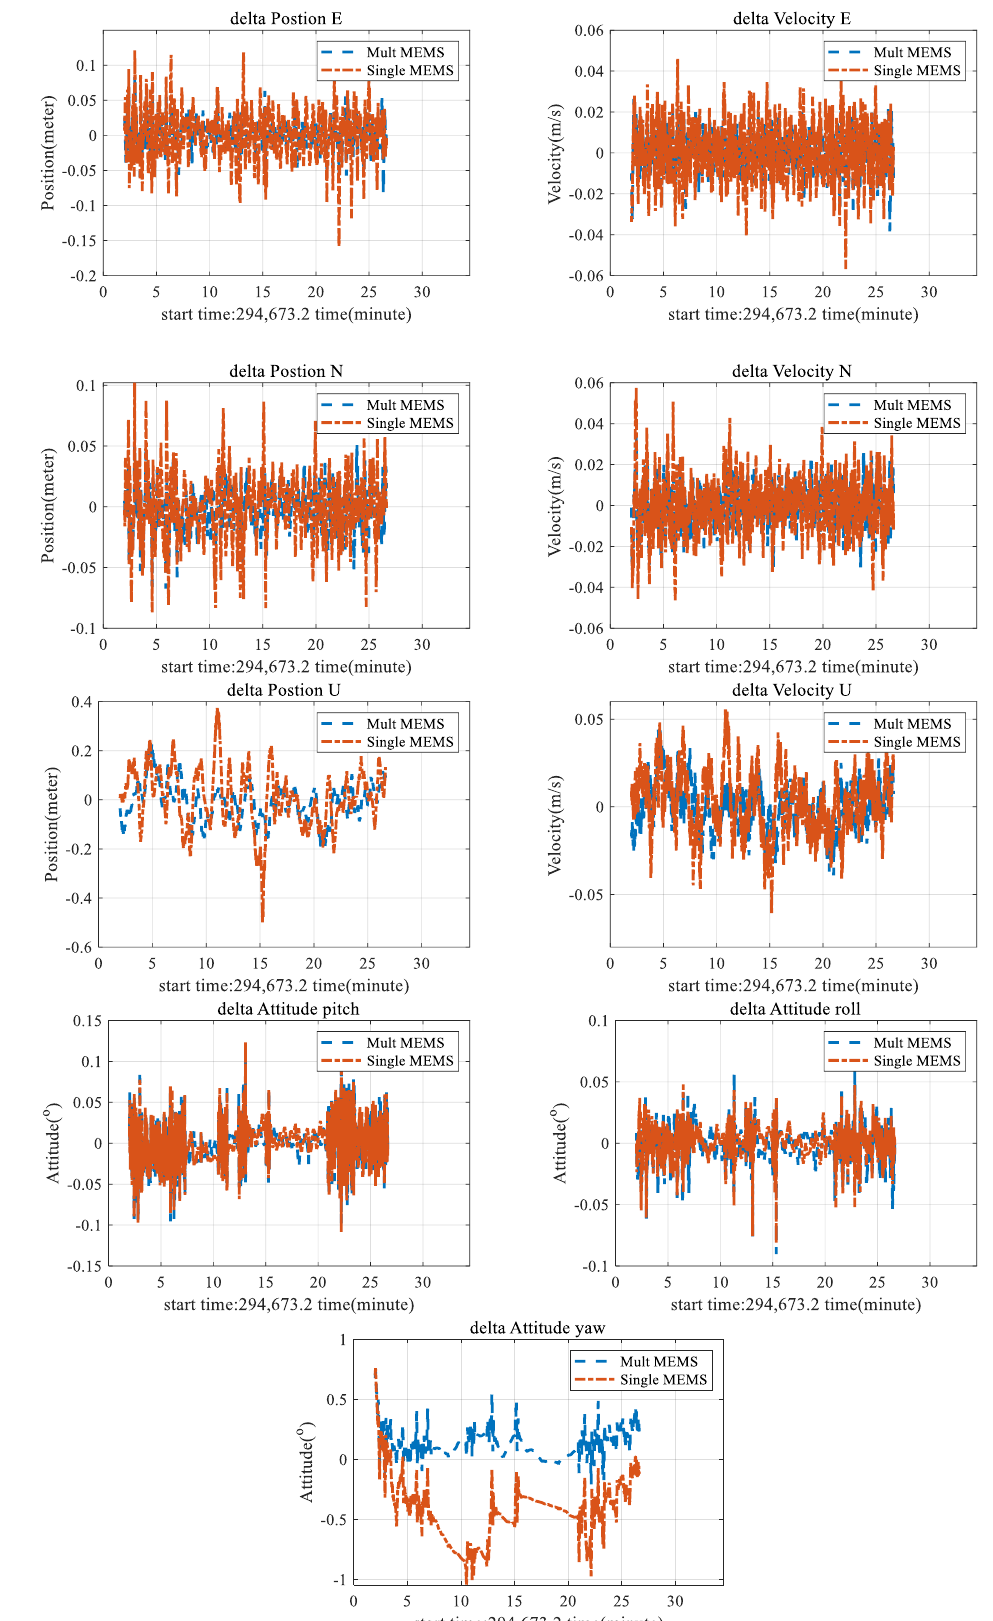
Figure A1. Deviation of position, velocity and attitude.